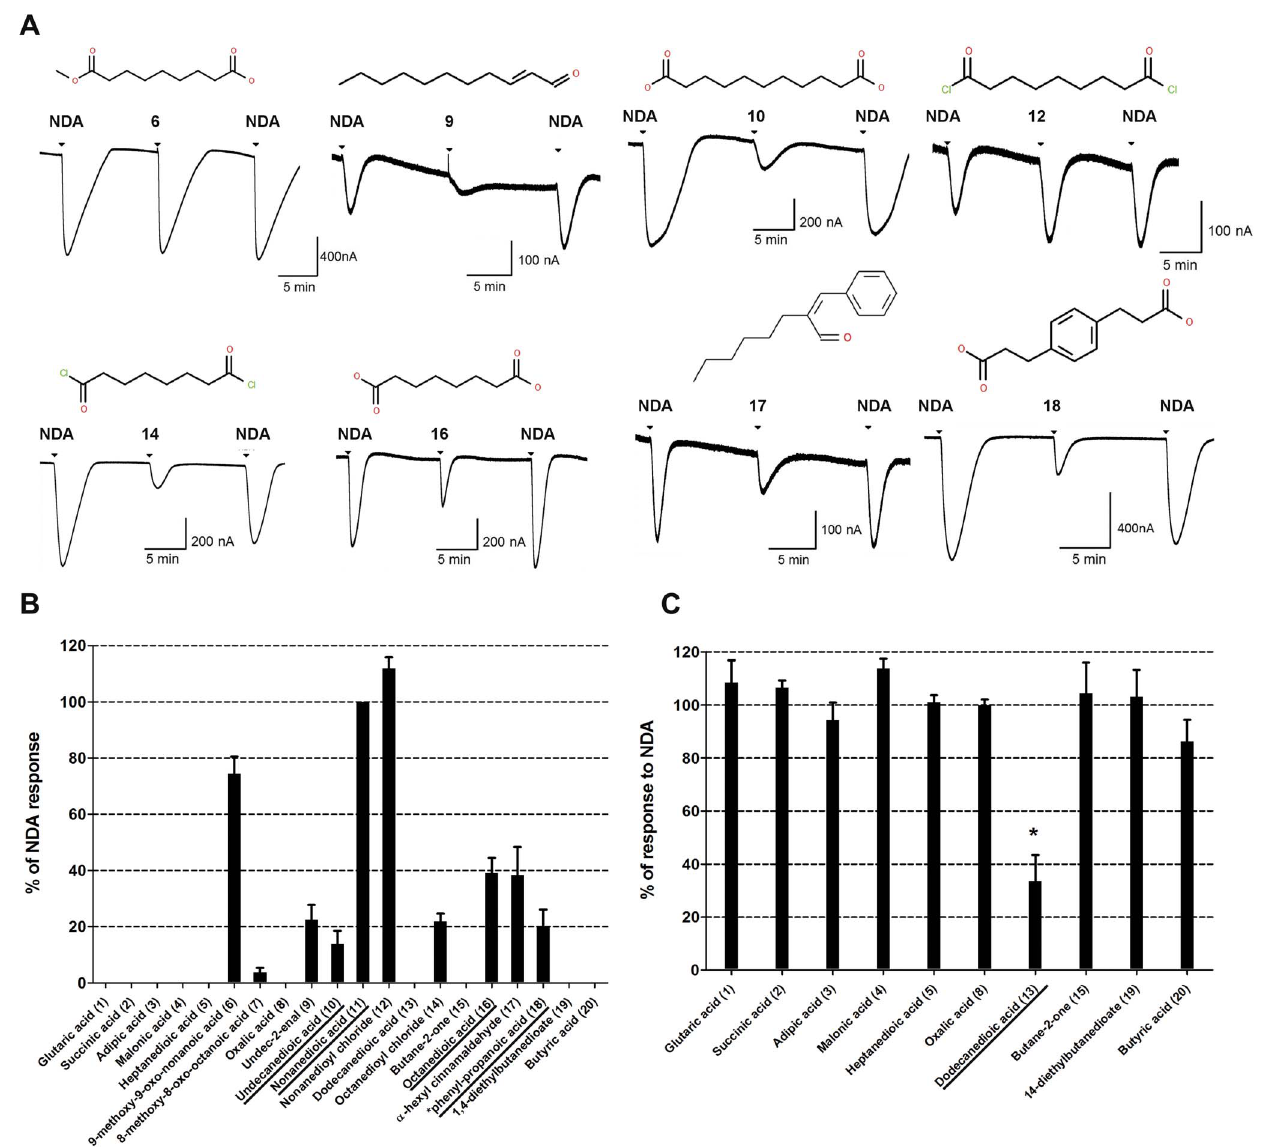
Figure 2. Invitro validation of insilico results. A. Representative traces of agonists, their structures and corresponding screen numbers tested at 100 m M for 15sec. Responses to 100 m M nononedioic acid (NDA) before and after application of each odorant was used for normalization. B. Histogram showing relative activity of the top 20 candidate ligands listed according to their score, tested at 100 m M and normalized to nonanedioic acid (mean 6 SEM, n=5–10). Compound 18 full name is * 3-(4-(2-carboxyethyl)-phenyl)-propanoic acid. C. Histogram showing responses of ligands tested as antagonists at 1mM concentration and in the presence of 10 m M NDA. Responses are expressed as % of the responses to 100 m M nonanedioic acid, mean 6 SEM, n=5–10. Compound 13 (dodecanoic acid) is an antagonist, *p , 0.05. This compound (underlined) was previously identified as an antagonist for MOR42-3 [18].